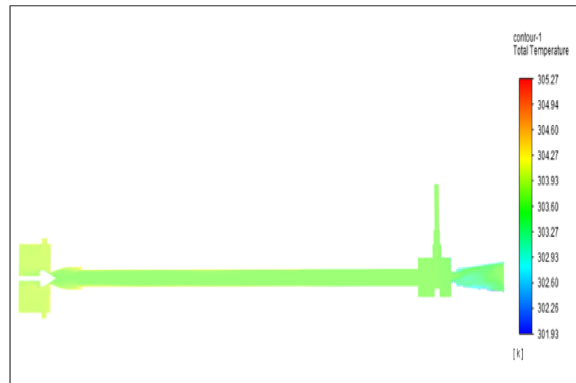
Figure 9. Bronze at 2 bar.